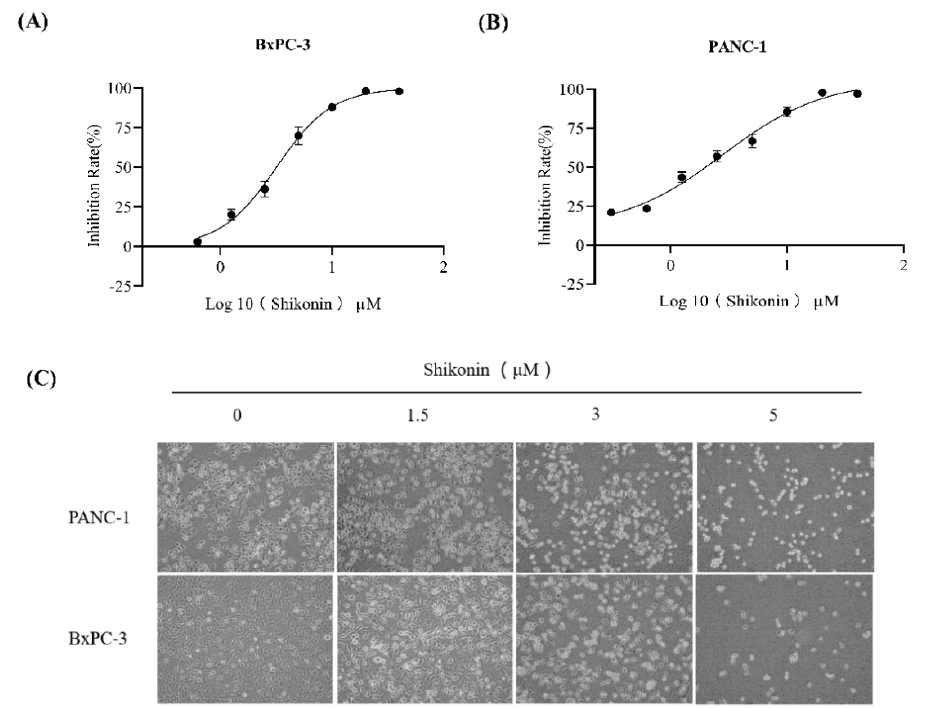
Figure 3. Effects of shikonin on pancreatic cancer cells. ( A ) BxPC − 3 and ( B ) PANC − 1 cells were treated with shikonin for 24 h and analyzed using MTT assay. ( C ) PANC − 1 and BxPC − 3 cells were treated with shikonin at 0, 1.5, 3, and 5 μM for 12 h, and images were captured under an Olympus inverted microscope. Results are means ± SD of three independent experiments.